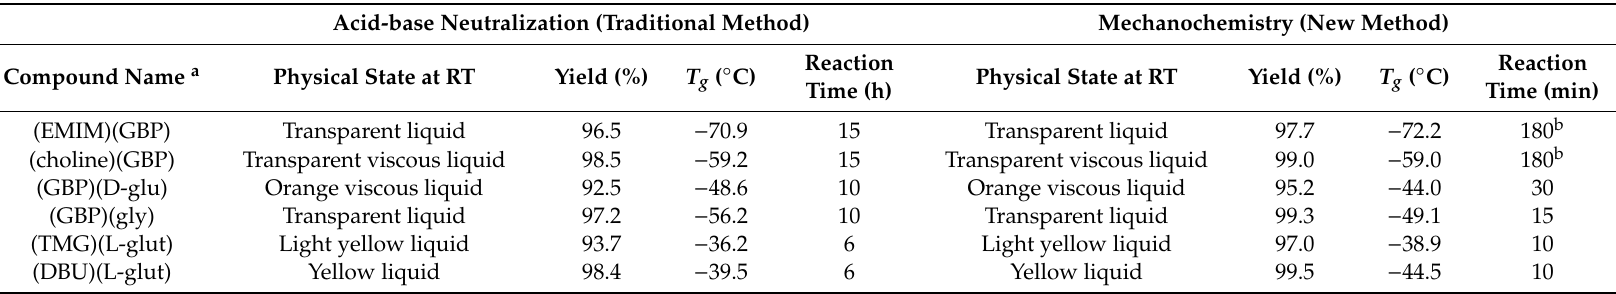
Table 2. Physical state, yield, thermal properties ( T g ), and reaction time obtained for all compounds in each synthetic method [46]. Acid-base Neutralization (Traditional